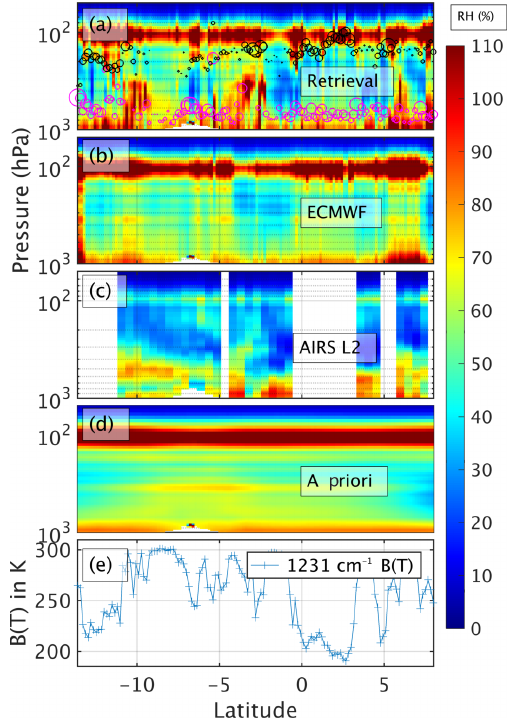
Figure 15. Comparing percent relative humidity (color bar) along track “B” in Fig. 9. From (a) to (e) we have our retrieval, ECMWF, the AIRS L2 retrieval and a priori humidity profiles. Panel (e) is a plot of the observed BT 1231cm − 1 channel. The black and red circles in (a) are the positions of ice and water clouds, with the circle size denoting the OD.